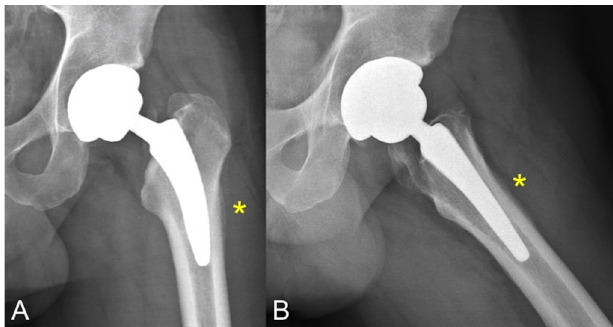
Figure 2. A and B. Anteroposterior (A) and lateral (B) x-ray views of the same patient ’ s hip at 8 months of follow-up depicting bone remodelling and periosteal reaction located at the lateral and anterior femoral cortices (*), which correlated with unremitting pain that exacerbated with axial loading. No signs of prosthesis subsidence or loosening can be